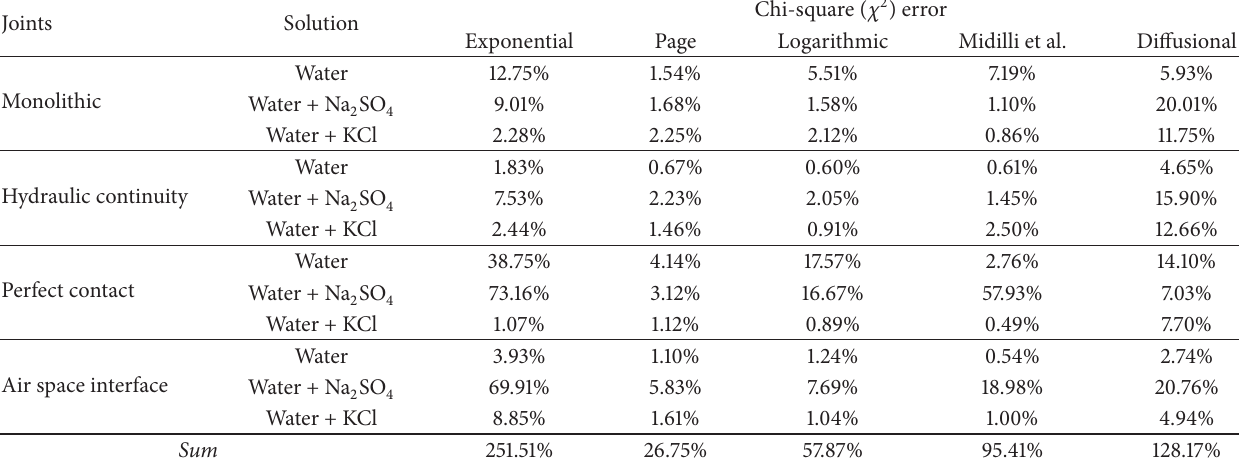
Table 4: Results of the statistical analyses obtained with the drying models